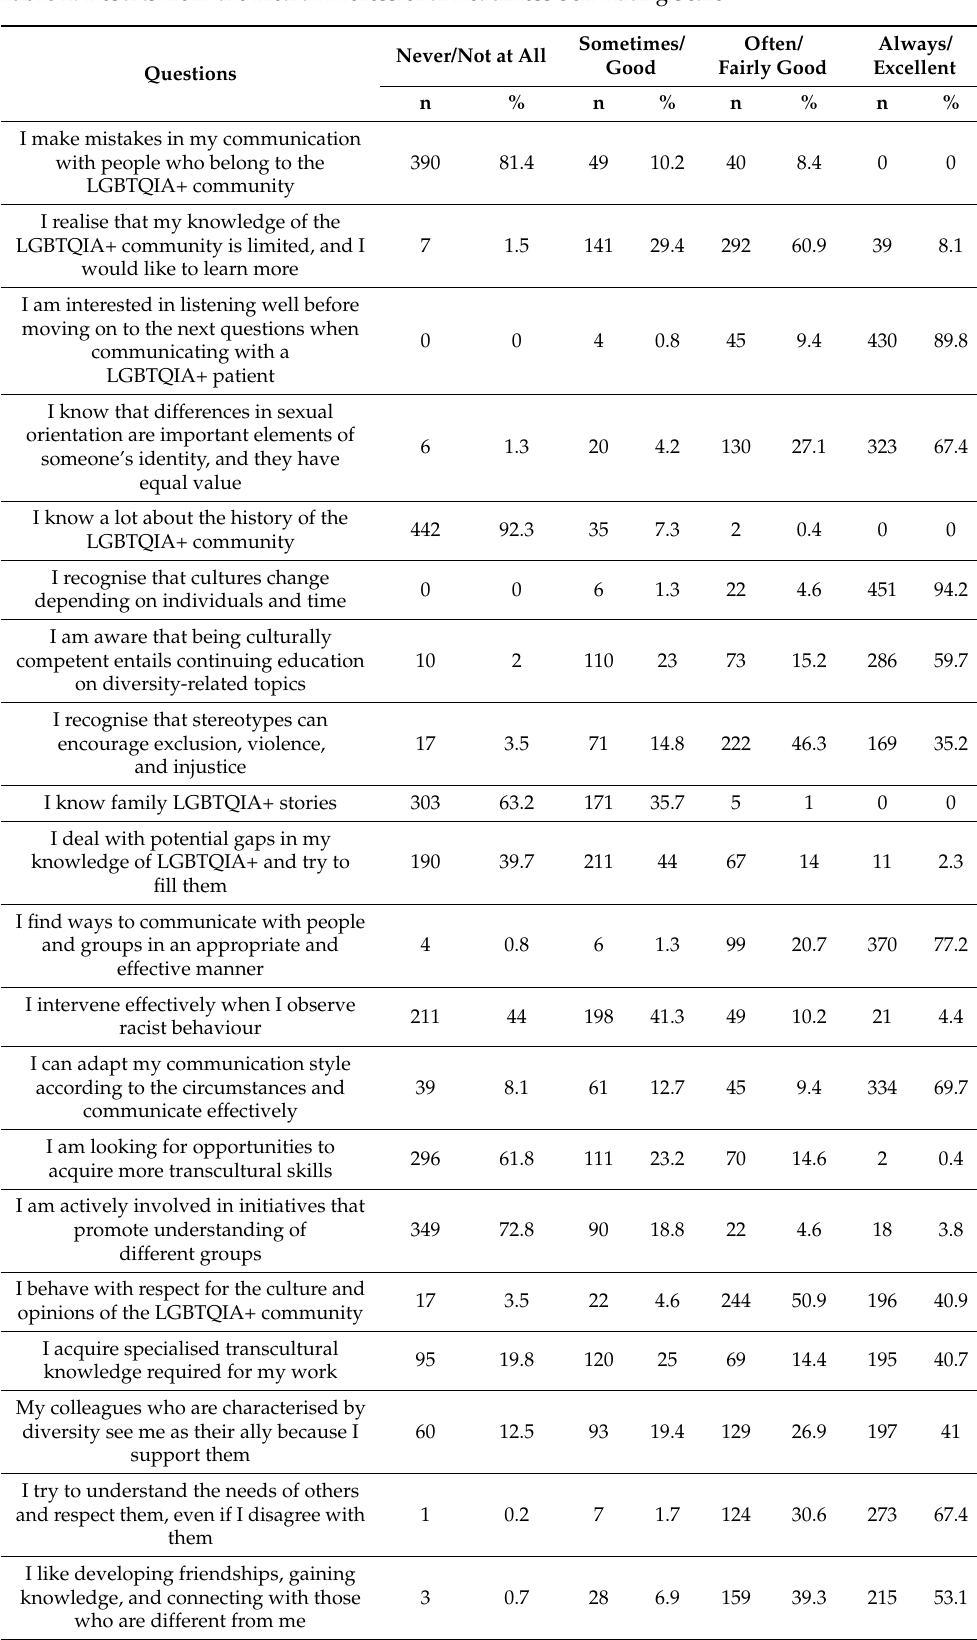
Table 2. Results from the Health Professional Readiness Self-Rating